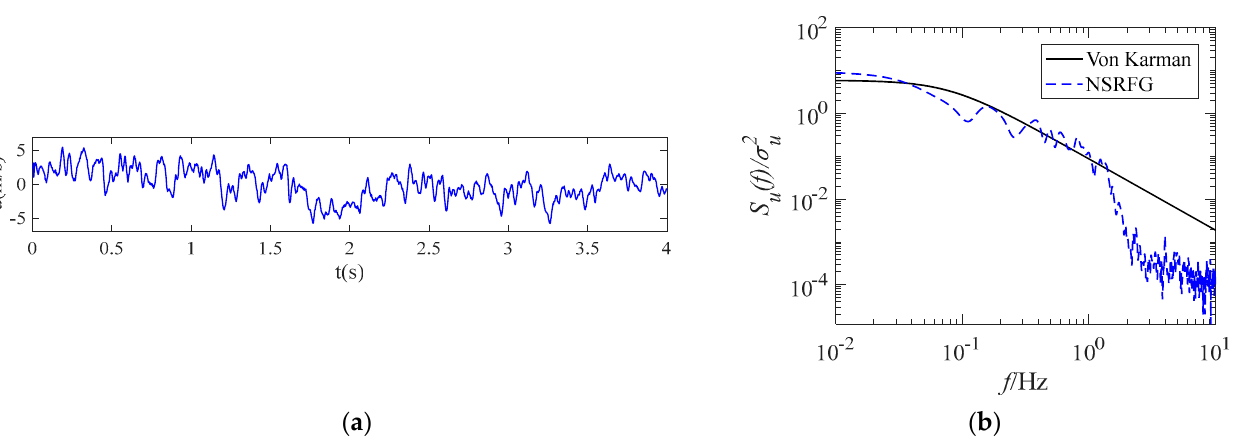
Figure 13. Wind velocity − time history and normalized power spectral density of the monitoring point Z 1. : ( a ) 0 − 4 s along − wind fluctuating velocity − time history; ( b ) Spectra of the along − wind fluctuating wind velocity.